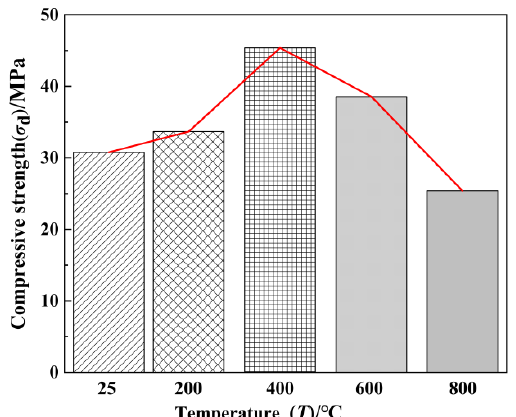
Figure 7. The relationship between uniaxial dynamic compressive strength and the temperature of lime- stone.